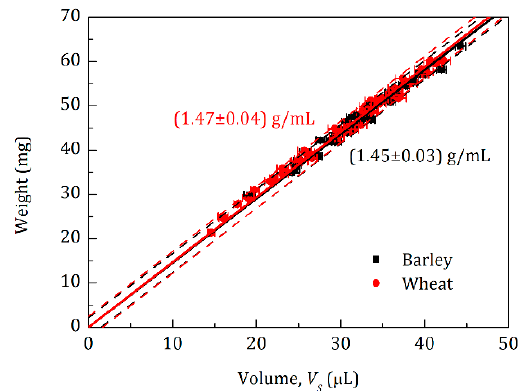
Figure 3. Measurements of 24 barley and 24 wheat seeds. The seeds were weighted using a balance with a precision of 0.1 µg. Volumes were measured by the initial sensor at 232 Hz using the corresponding calibration curve depicted in Figure 2. Right-black and left-red numbers (value ± standard deviation), representing the densities for barley and wheat seeds, respectively, were obtained by a linear fit with zero intercept applied to the black and red data points, respectively. Dashed lines reflect 95% prediction bands for both of the sets.